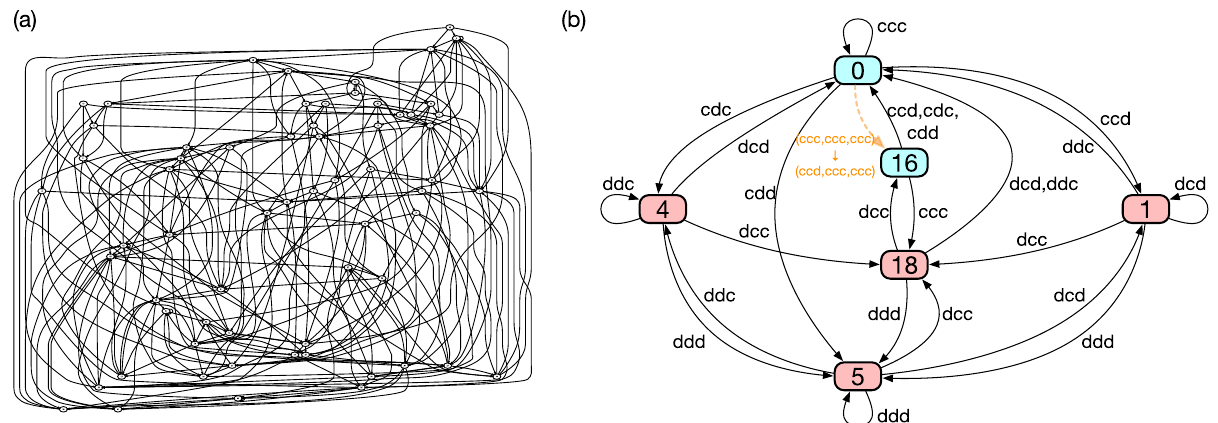
Figure 5. Two representations of one of the PS2’s for the iterated three-person PG game. ( a ) History-based representation. As a memory-two strategy for a three-person game, it has 2 6 = 64 nodes, each of which has four outgoing links. Note that it is practically impossible to extract useful information from this representation even for n = 3 and m = 2 . ( b ) State-based representation. The colour and the number of each node are depicted in the same way as in Fig. 4b. State ‘1’ and ‘4’ are symmetric under the exchange of the co-players. Although error-caused transitions are not represented by this automaton, we depict an erroneous action ( ccc , ccc , ccc ) → ( ccd , ccc , ccc ) for readers’ convenience as a dashed orange